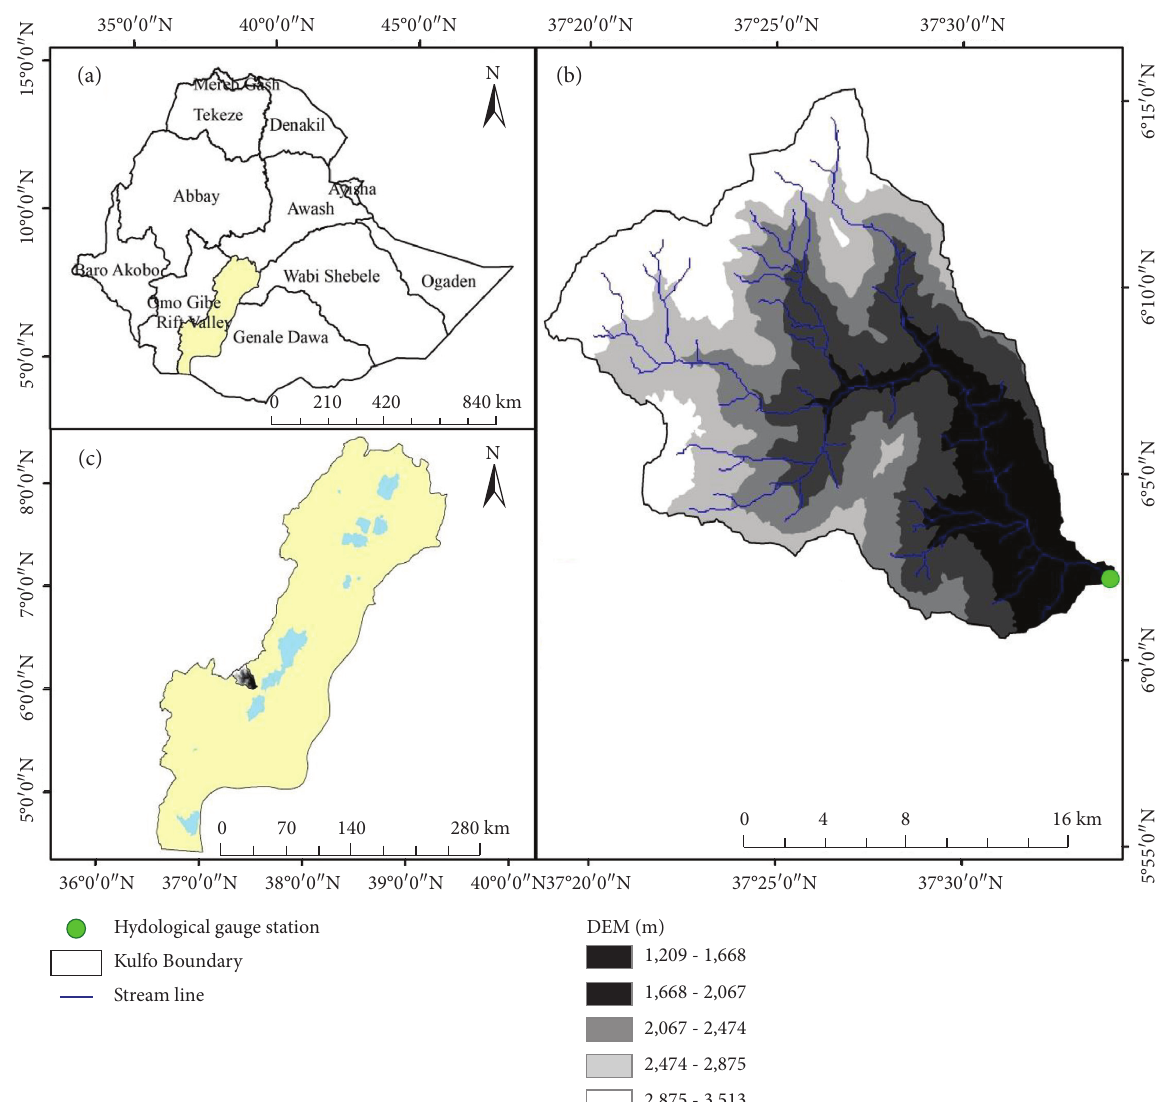
Figure 1: Study area: (a) major Ethiopian basins, (b) Kulfo watershed with its drainage lines, and (c) rift valley basin and lakes. Table 1: Data length and locations of meteorological stations used. S.